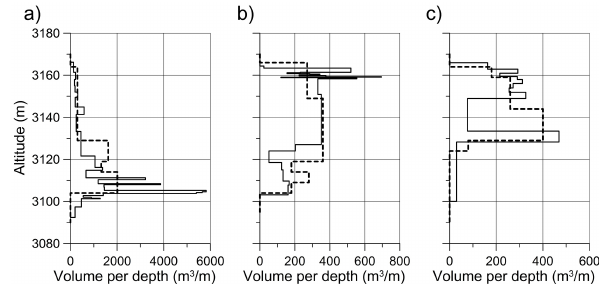
Fig. 11. Water volume per unit depth extracted from different depth intervals (solid line) and water volume per unit depth es- timated with the 3-D-SNMR (dashed line): (a) August–October 2010; (b) September–October 2011; (c) August 2012.